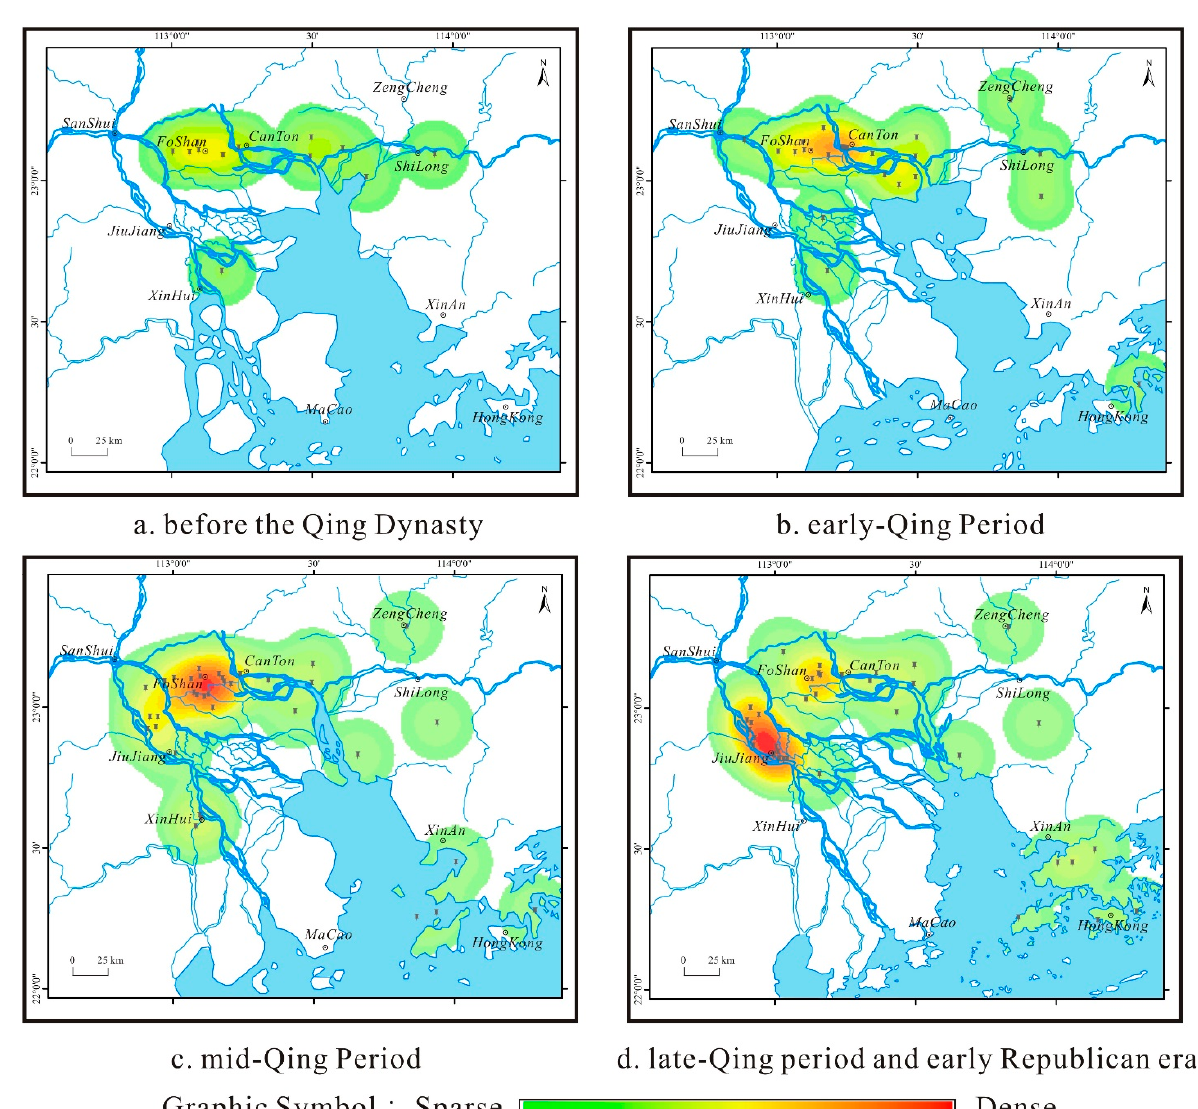
Figure 3. The process of the spatiotemporal evolution of Nanhaishen Belief. 3